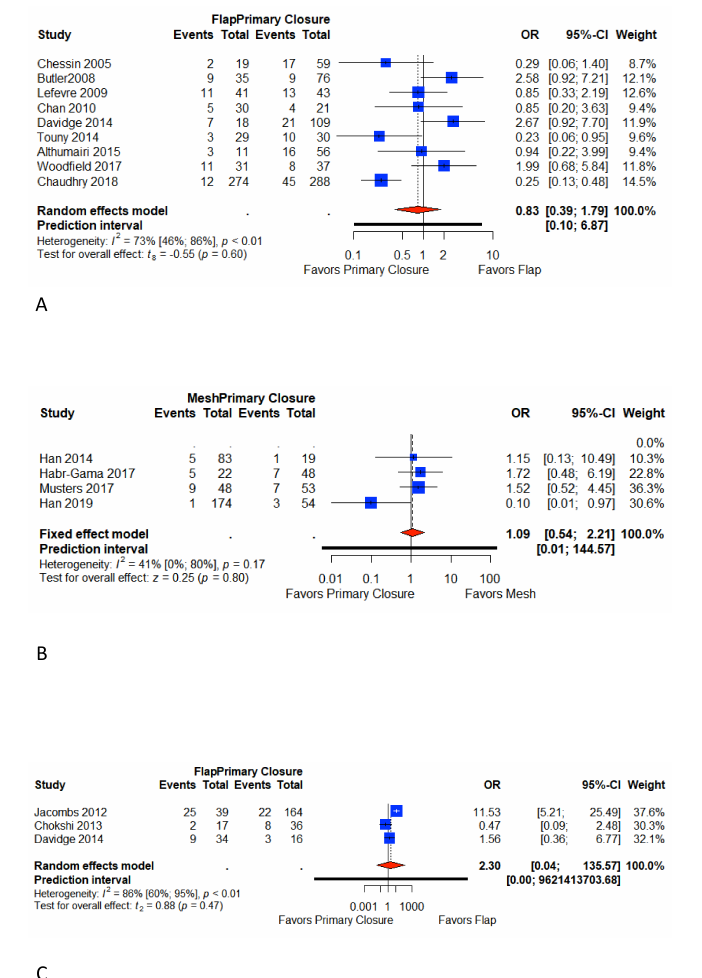
Figure 4. Forest plot for minor perineal wound complications between patients with primary closure and with flap closure ( A ); forest plot for minor perineal wound complications between patients with primary closure and with mesh closure ( B ); forest plot for minor perineal wound complications between patients with primary closure and with flap closure in pelvic exenteration ( C ). Odds ratio: overall ratio of minor perineal wound complications when comparing primary closure with flap closure. All weights are from random effects analysis. M–H, Mantel–Haenszel.